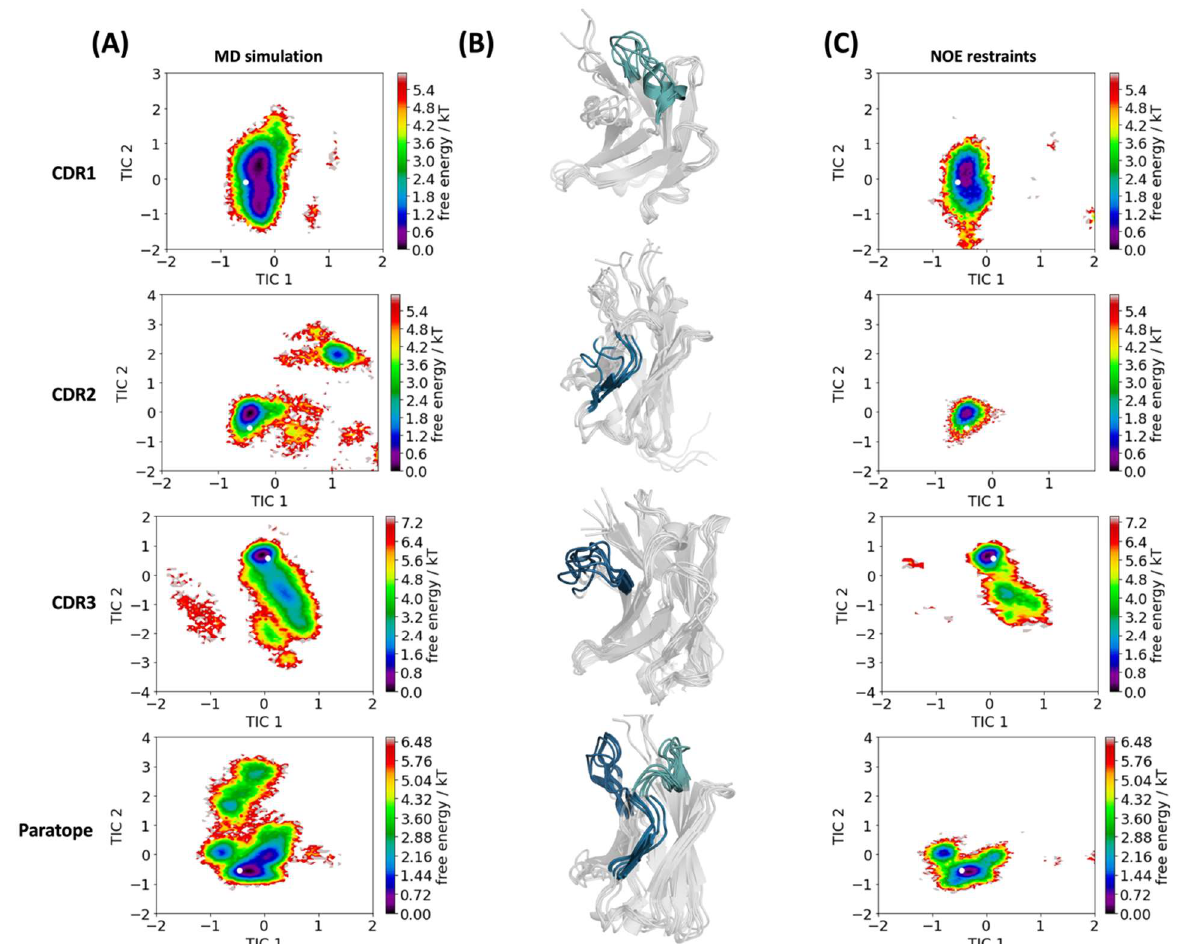
Figure 2. Free energy surfaces of the simulated MD ensemble ( A ) and the simulated NMR ensemble ( C ). Combined tICA of the simulated MD ensemble and the simulated NMR ensemble was performed to generate kinetic coordinate systems for each CDR loop and the whole paratope. tIC1 and tIC2 represent the directions of the two slowest movements of the system. The crystal structure is projected into these coordinate systems and illustrated as a white dot. ( B )The respective structure representatives of the simulated MD ensembles are shown in the middle, focusing on the respective CDR loops.